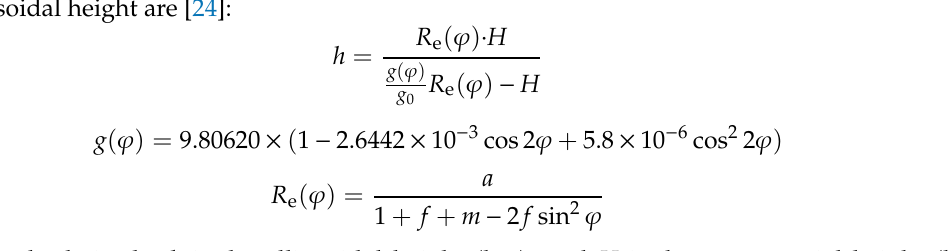
Figure 1. The radiosonde data, with a resolution of 12 h (at UTC 00:00 and 12:00), can be obtained in the websites of the University of Wyoming (http: // weather.uwyo.edu / upperair / sounding.html). To calculate the time series of ZTD, the geopotential height, atmospheric pressure, temperature, and relative humidity data on each pressure level from radiosonde data are needed. The calculation steps are shown in Equations